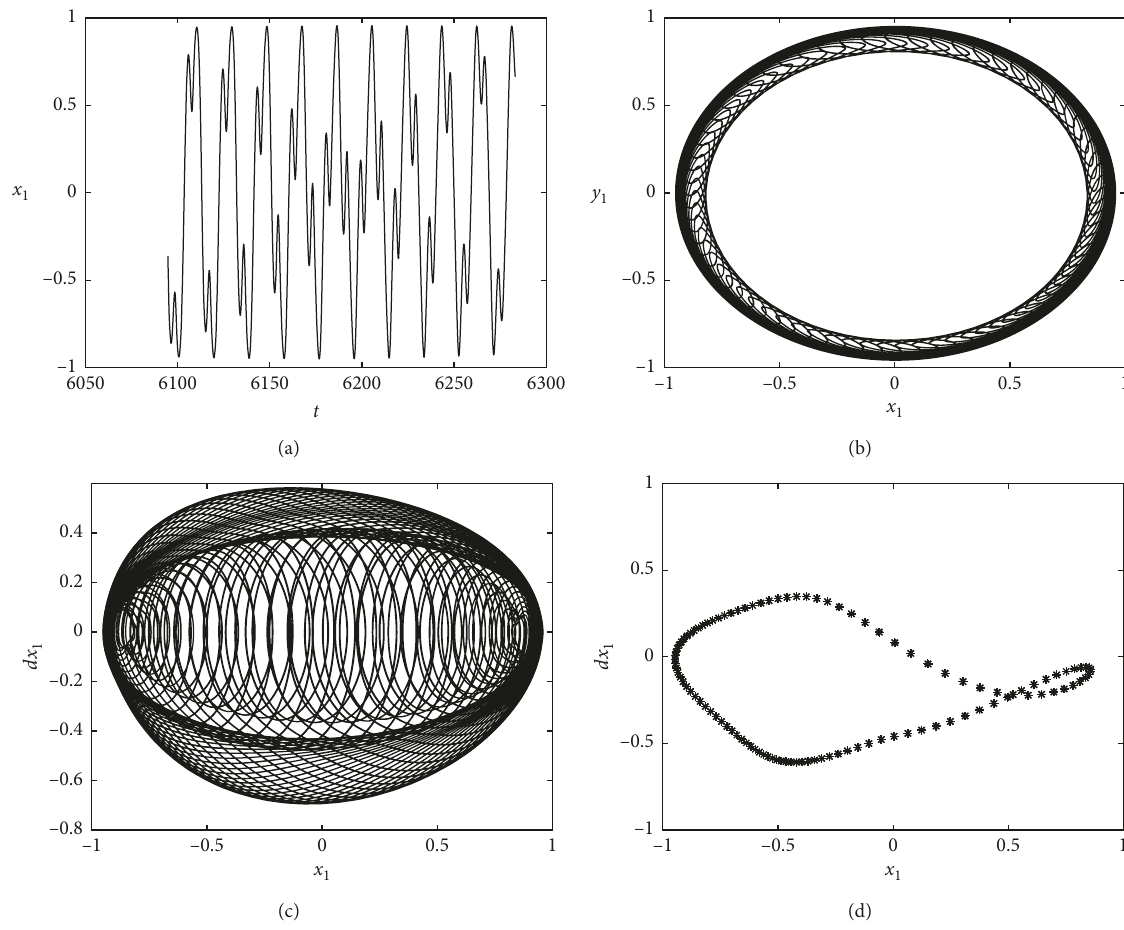
Figure 6: Response of the rotor system when ω � 2000rad/s.